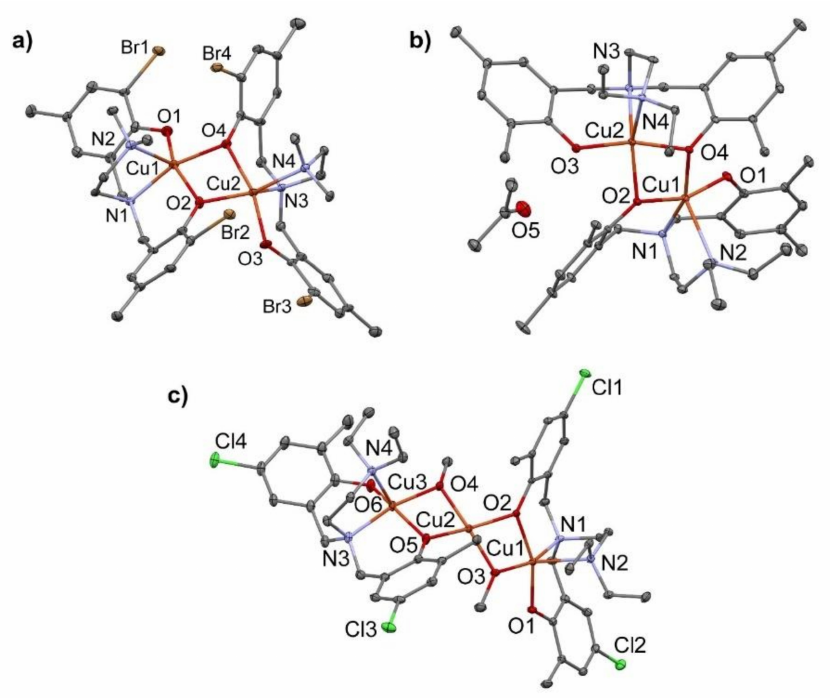
Figure 1. Perspective views of ( a ) 3 , ( b ) 4 , and ( c ) trinuclear subunit of 9 . Table 1. Selected bond distances (Å) and angles ( ◦ ) of 3 , 4 , and 9